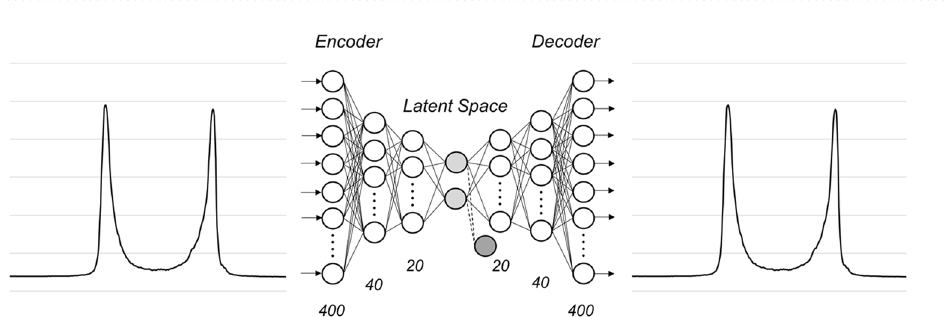
Figure 2. The VAE model implemented in this study. The input data has 400 dimensions, and this layer is connected to 2 hidden layers (light gray circles) with 40 and 20 dimensions, respectively (encoder). The encoder is connected to two dimensional gaussian distributions represented by the mean and logarithmic variance-covariance matrix in a latent space. The decoder reconstructs the ORA waveform data from the latent variables on 400 dimensions through 2 hidden layers with 20 and 40 dimensions respectively. VAE: variational